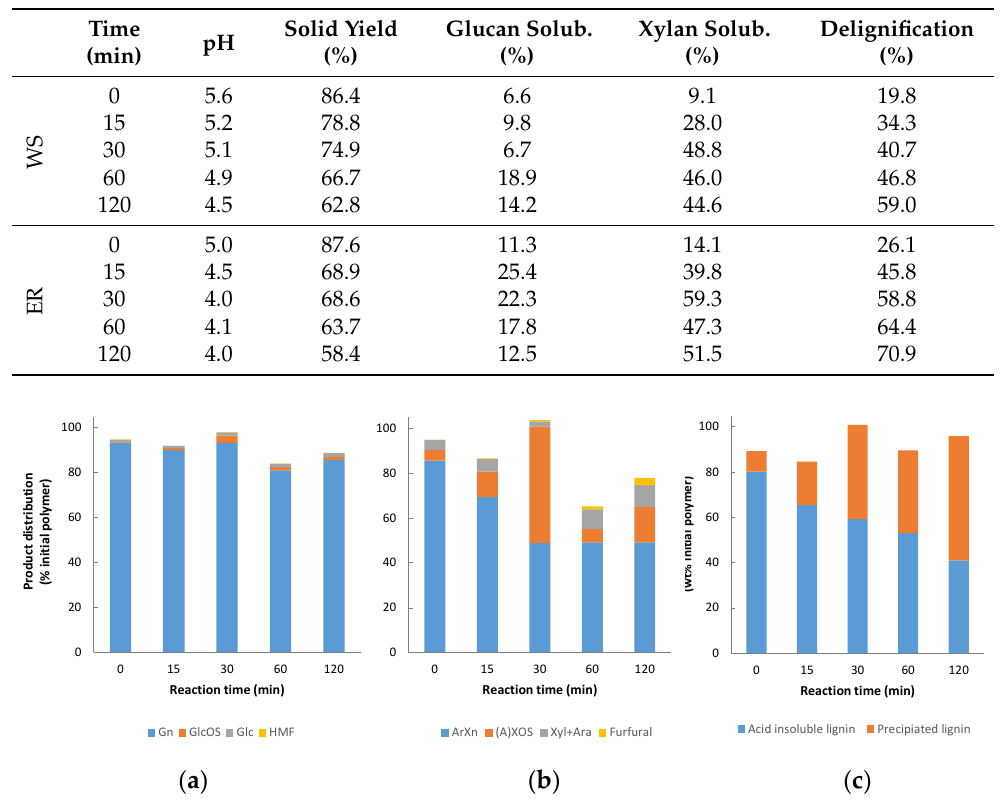
Figure 2. Product distribution obtained for wheat straw (WS) using ethanol-based organosolv fractionation (no catalyst added) for glucan ( a ), (arabino)xylan ( b ), and lignin ( c ). Gn, glucan; GlcOS, gluco-oligosaccharides; ArXn, (arabino)xylan; (A)XOS, xylo-oligosaccharides (arabinosyl-substituted); Glc, glucose; Xyl, xylose; Ara, arabinose; HMF, 5-hydroxymethylfurfural.